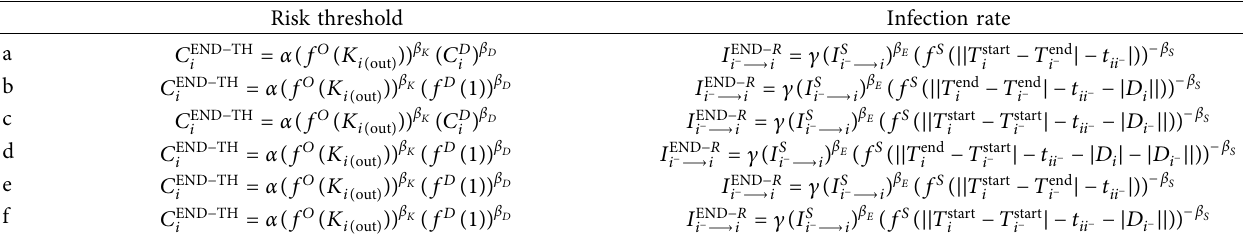
Table 1: Risk threshold and infection rate in six